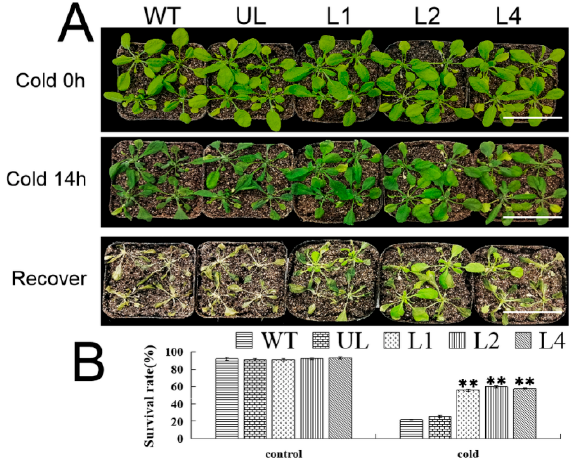
Figure 8. Growth of FvMYB114 -OE A. thaliana after salt stress. ( A ) The phenotypes of WT, UL and transgenic lines (L1, L2 and L4) under control conditions, cold stress and stress recovery conditions. Bar = 5 cm. ( B ) Survival rates of each line (WT, UL, L1, L2 and L4) under different treatments. ** SD between transgenic lines and WT and UL, p ≤ 0.01.